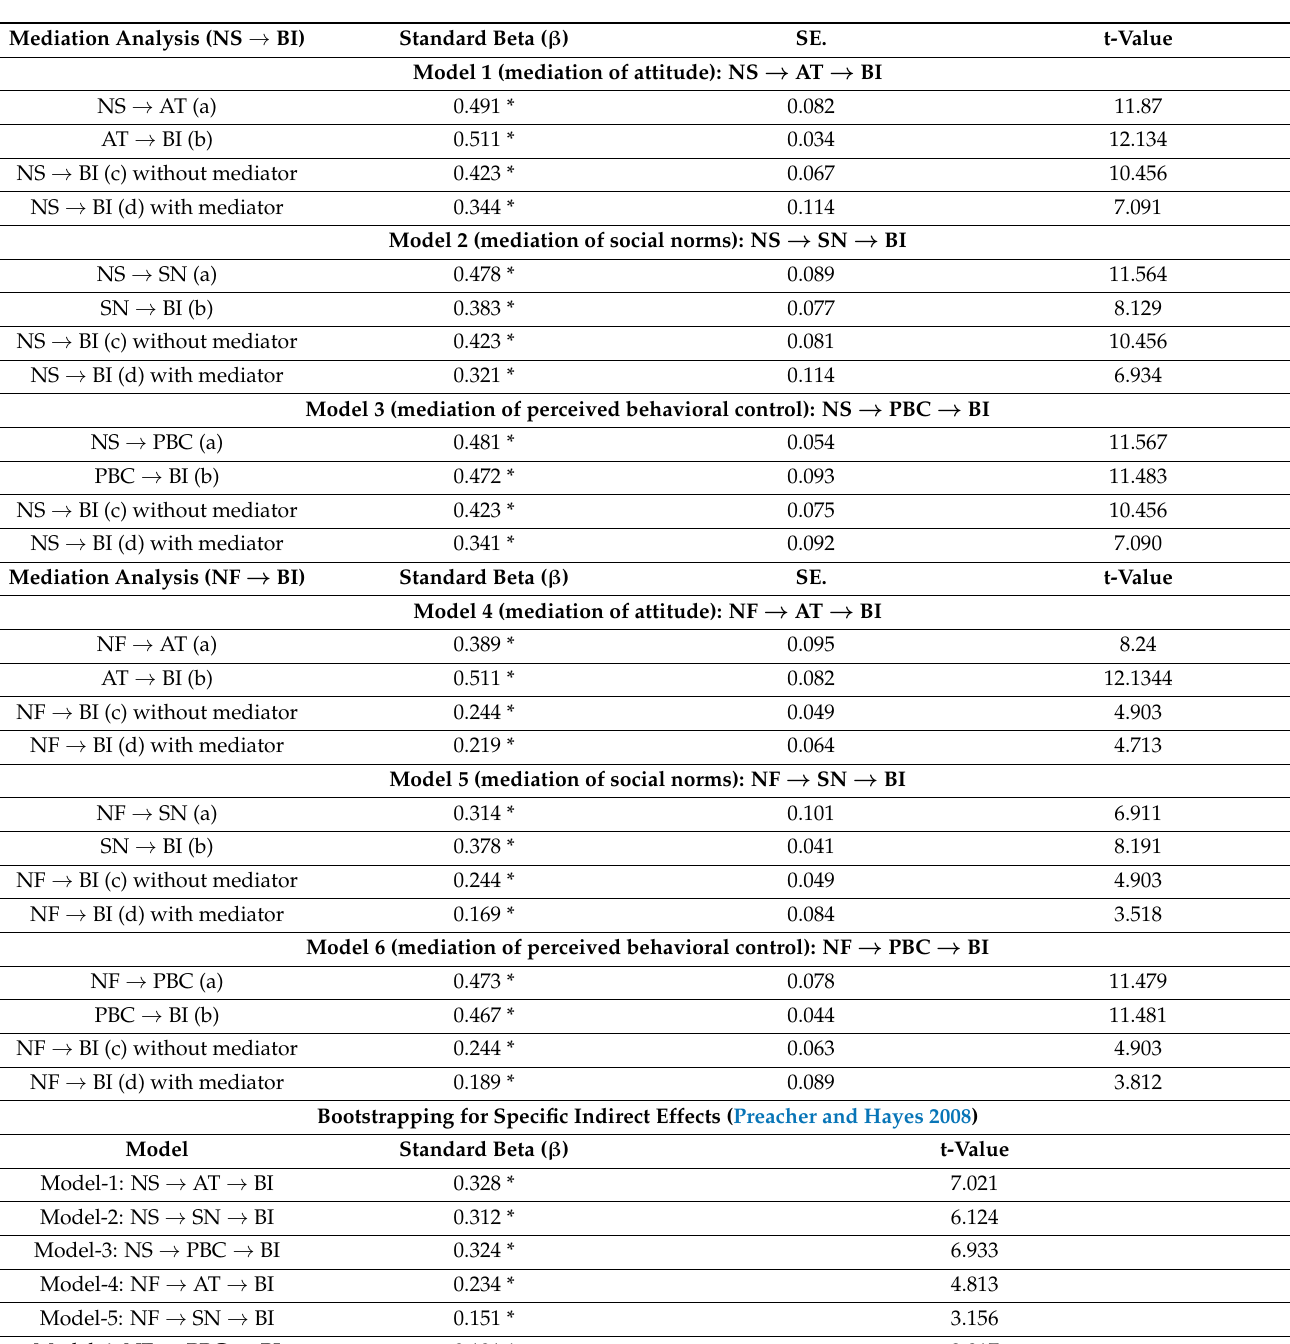
Table 5. Mediation test